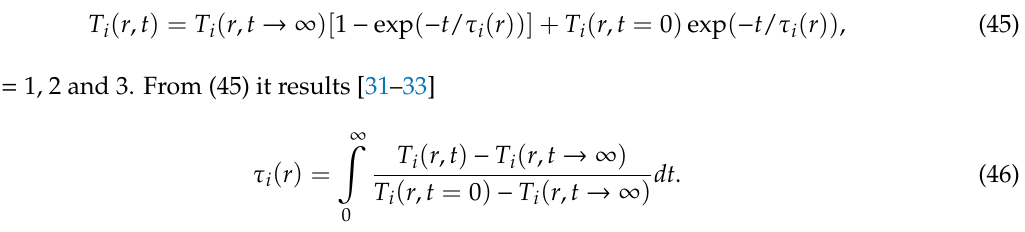
ρα . ρα and ),( ρα , ),( LL MM HH